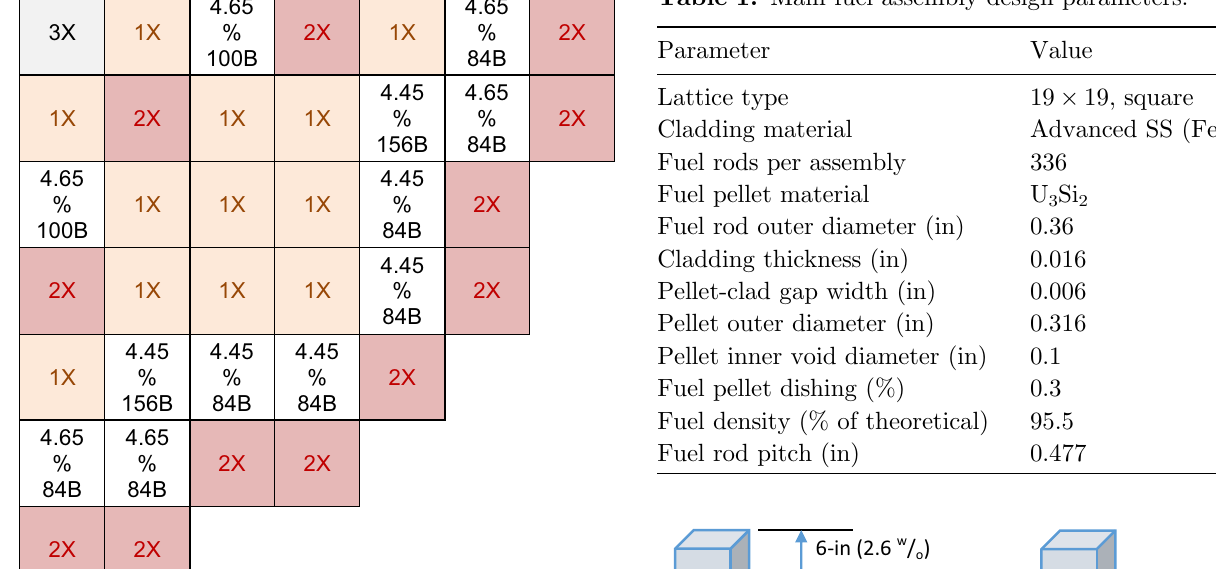
Table 1. Main fuel assembly design parameters.